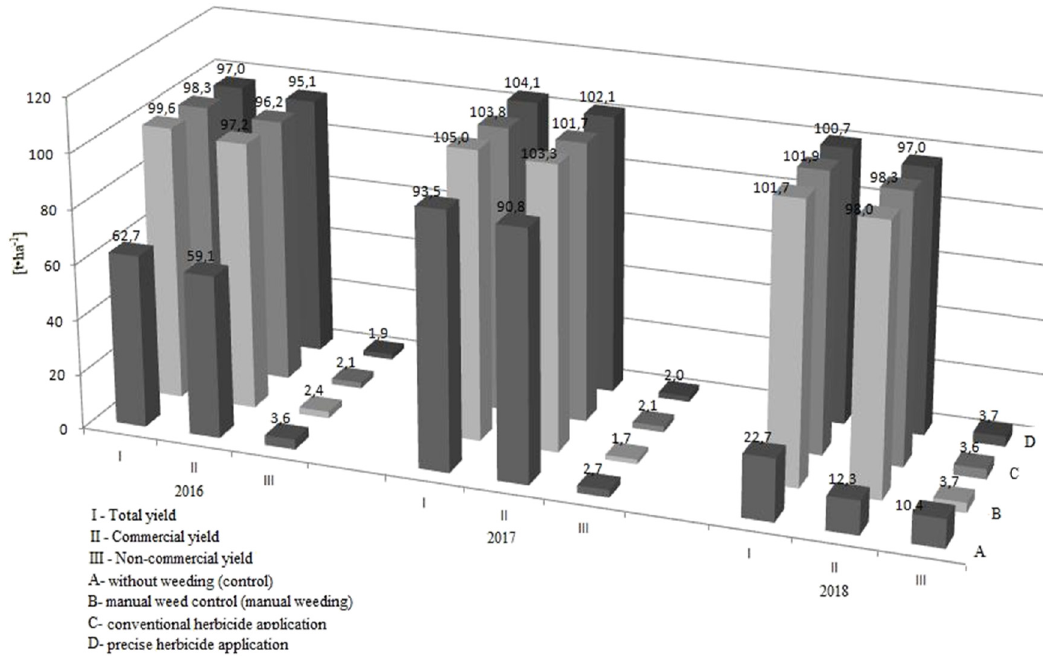
Figure 4: Average carrot yield ( source: own work ) .